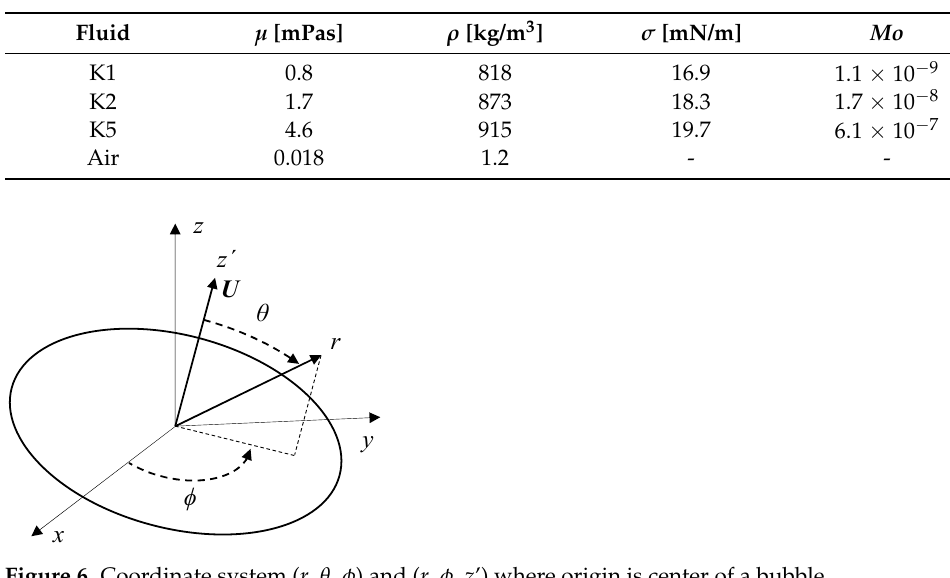
Table 3. Characteristics of fluids in present computation.